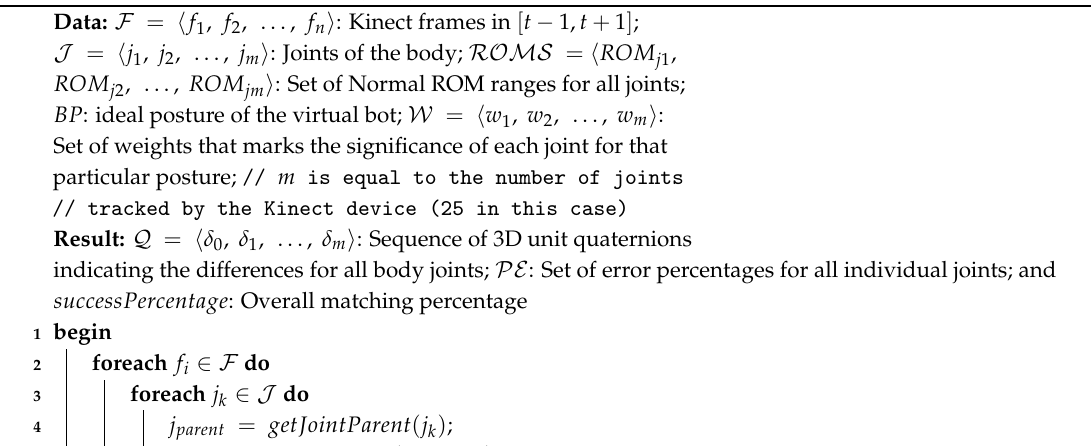
Algorithm 2: Posture Matching